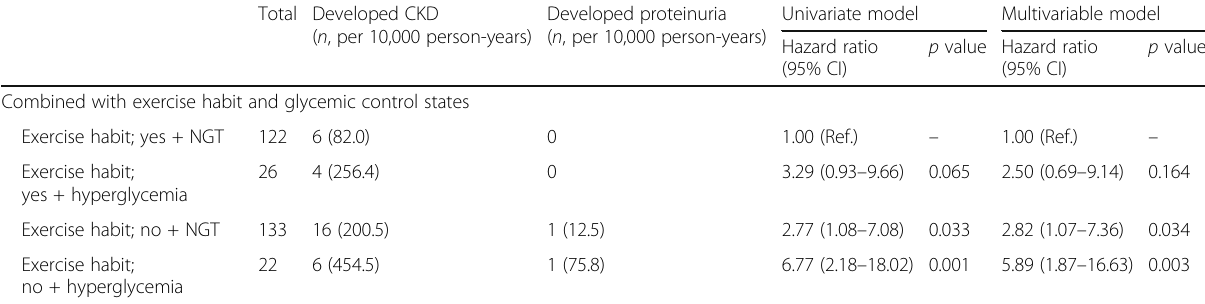
Table 4 The influence of the combination of an exercise habit and the glycemic control on the incidence of CKD Total Developed CKD Developed proteinuria Univariate ( n , per 10,000 person-years) ( n , per 10,000 person-years)